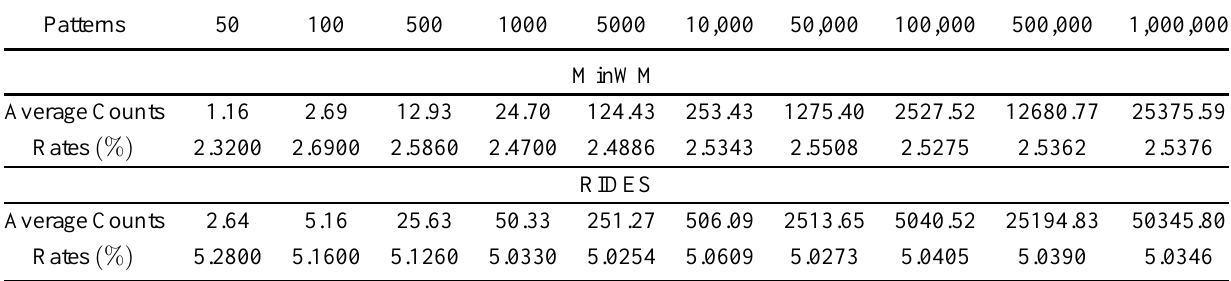
Table 2. The number of alerted patterns that require actual